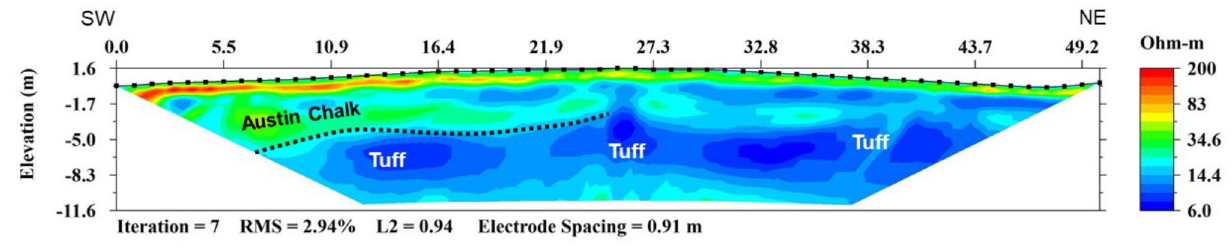
Figure 13: Resistivity data along profile P10. Note that resistivity layers are horizontal and a conduit-like intrusive anomaly observed on profiles P8 and P9 is absent from this profile.